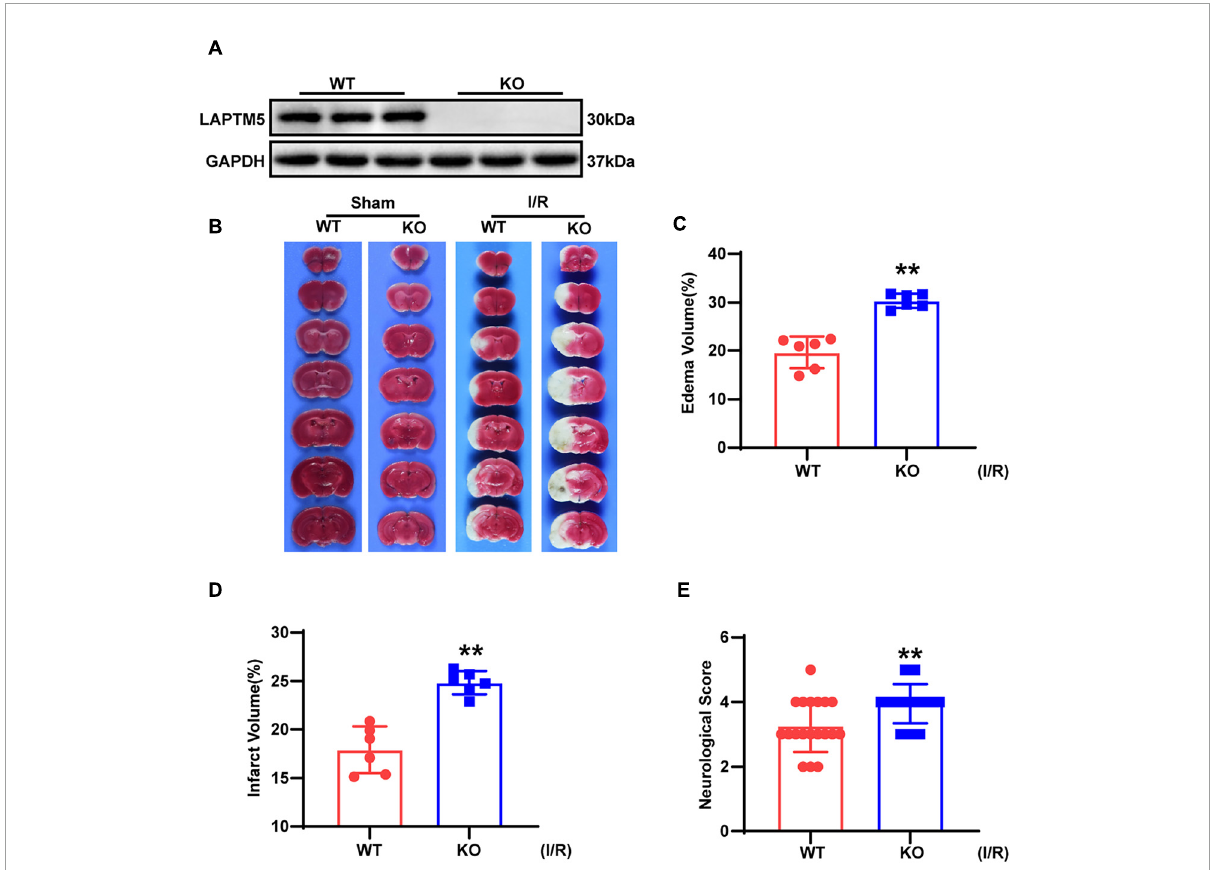
FIGURE2 LAPTM5 ablation aggravates cerebral I/R injury. (A) Western blot of LAPTM5 expression in brains from WT and LAPTM5-KO (knockout) mice, n = 3 mice per group. (B) Representative images of brain TTC staining, n = 6 mice per group. (C–E) LAPTM5-KO mice showed larger edema (C) ( n = 6 mice per group, ** p < 0.01, vs. WT I/R) and infarct volumes (D) ( n = 6 mice per group, ** p < 0.01 vs. WT I/R) and more severe neurological deficits based on function evaluation (E) ( n = 19–20 mice per group, * p < 0.05 vs. WT I/R) following I/R.